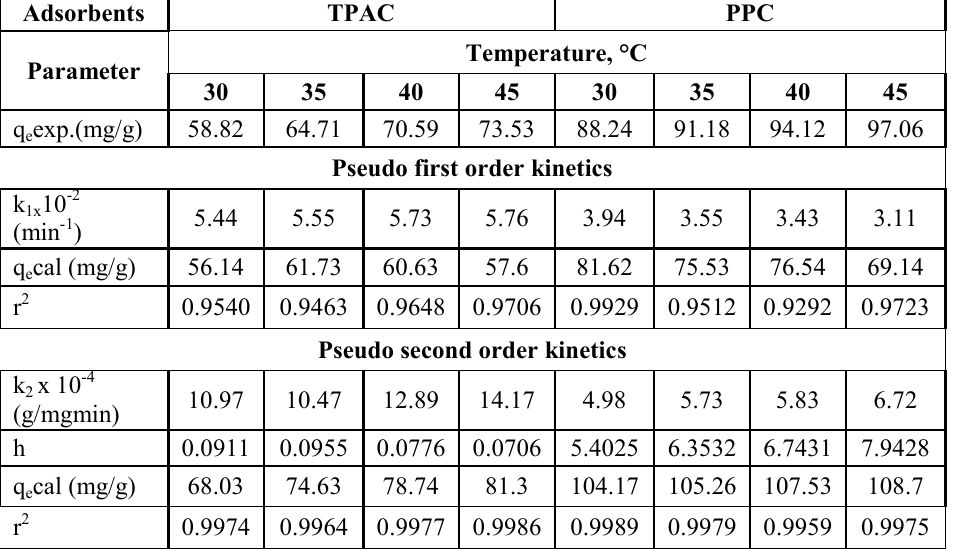
Table 2(b). Kinetic parameters for the adsorption of direct dye DB 71 onto TPAC and PPC with different temperatures at initial dye concentration of 50mg/L.